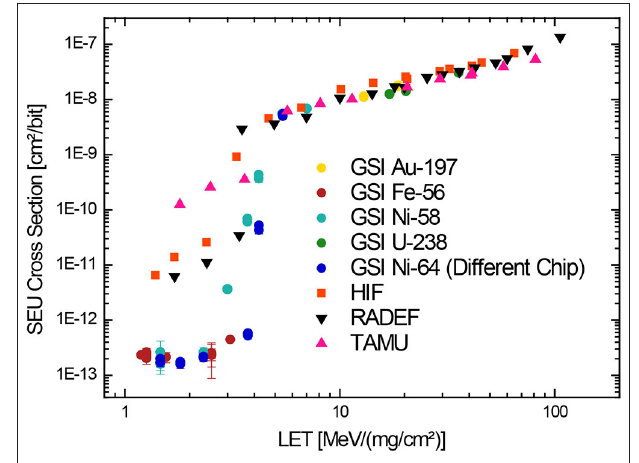
FIGURE 1 | Measured SEU cross section for block 3 of the Sandia 256 kbit SRAM taken with low energy (BNL) and high energy (TAMU) heavy ions [12]. Reproduced with permission from IEEE.